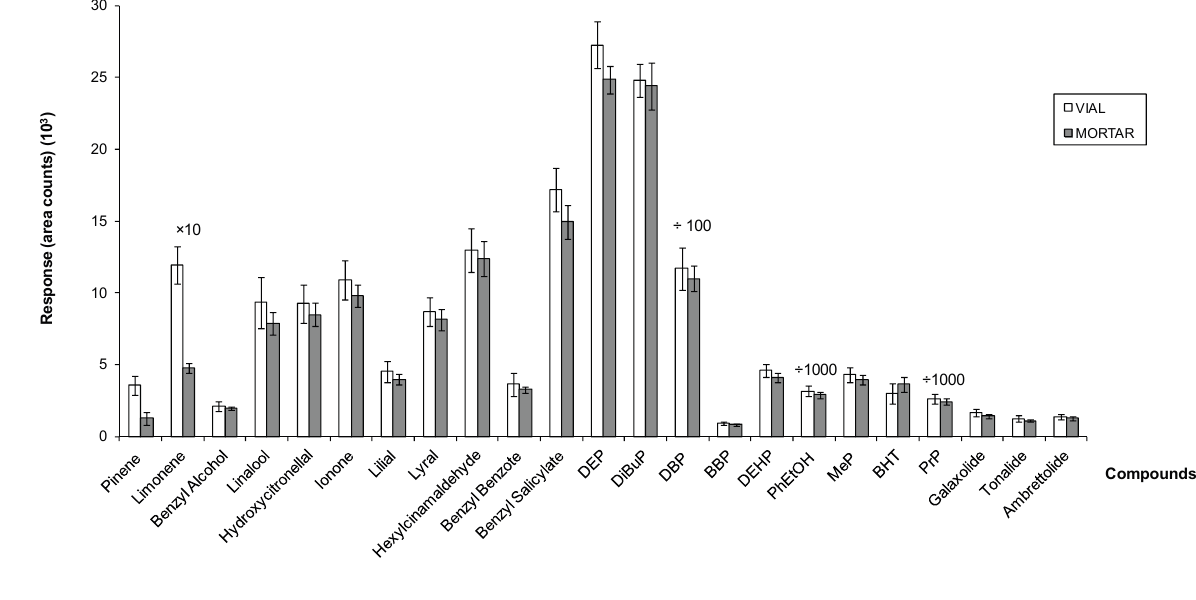
Figure 3. Comparative results between in vial or mortar µ-MSPD for a leave-on sample (hands